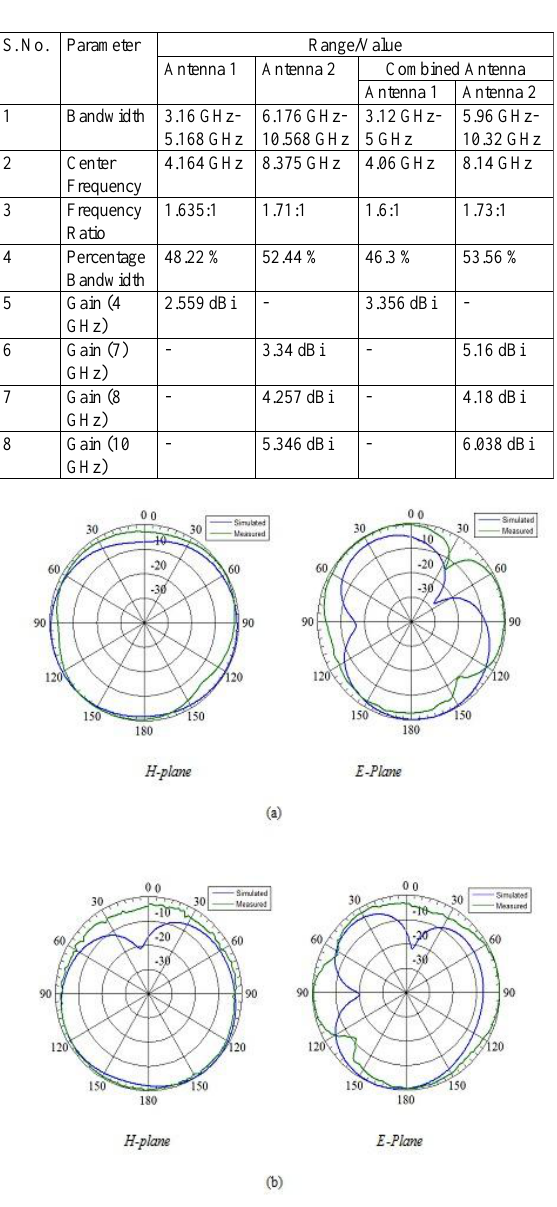
Fig. 13 :Radiation pattern of Antenna-2 at (a)7 GHz (b)9